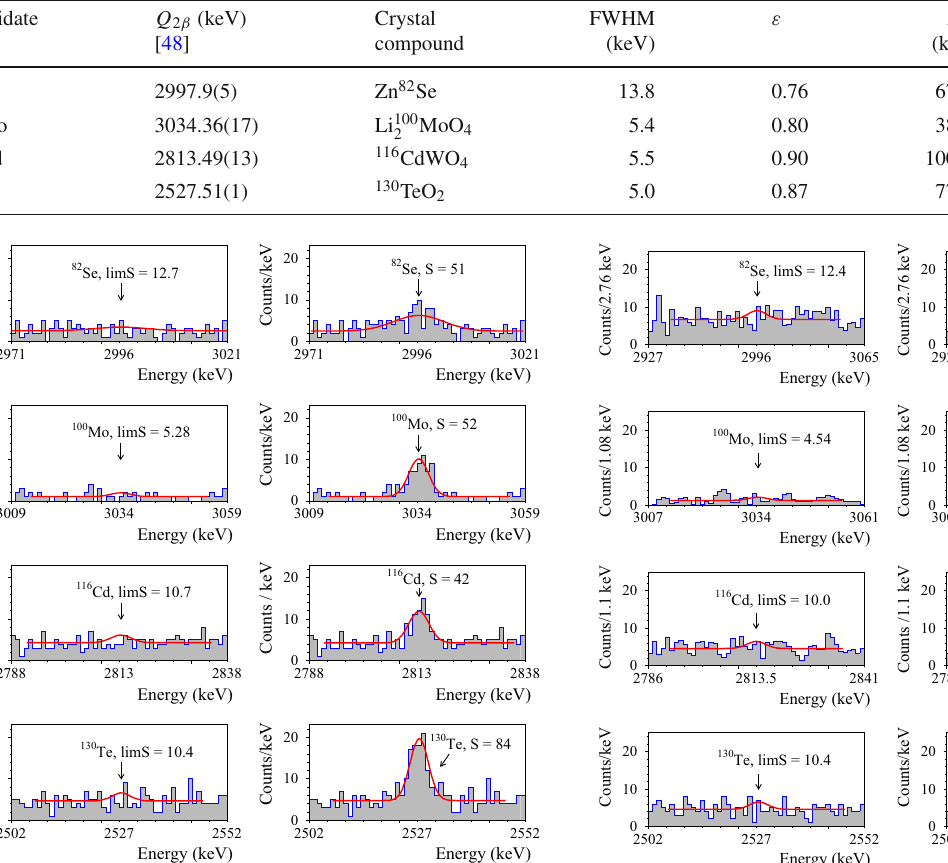
The considered parameters are the FWHM energy resolution at Q 2 β (FWHM), the detection efficiency ( ε ), the detector mass ( M ) and the number of nuclei of interest ( N )